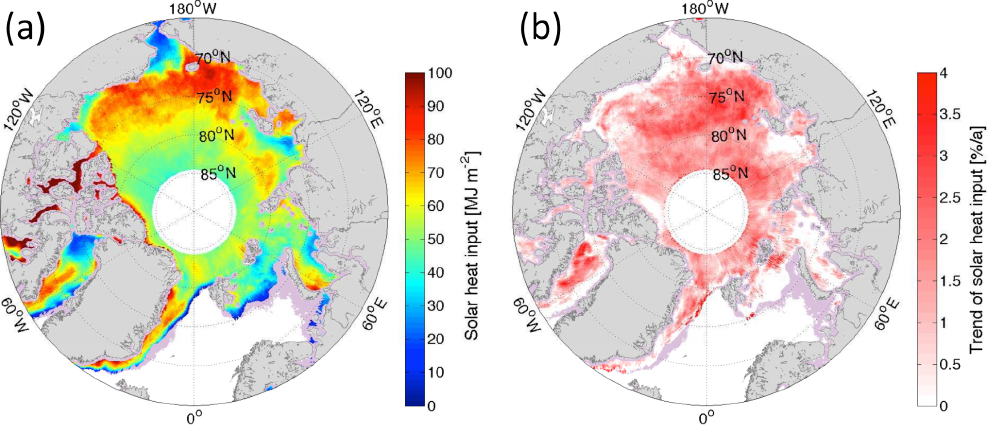
Figure 4. Annual total solar heat input ( Q T (x,y) ) through Arctic sea ice. (a) Average and (b) trend from 1979 to 2011. The trend is normalized for the trend in sea ice concentration. Purple shaded areas were not covered with sea ice during the maximum extent in all years.